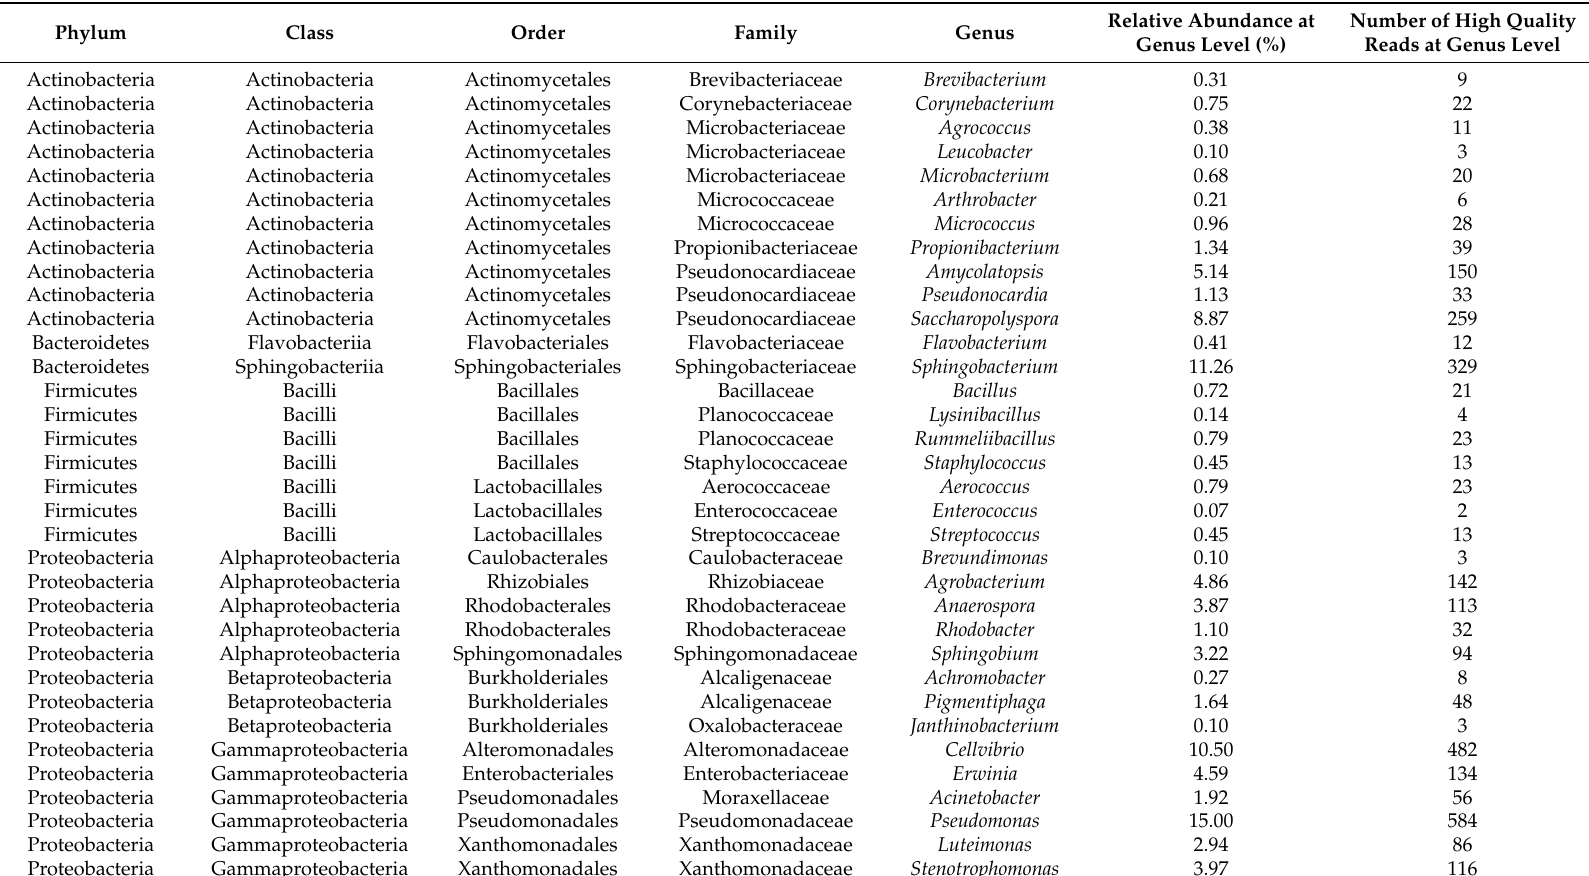
Table 1. List of all of the bacteria identified at the deepest reachable taxonomic level in the bone sample by 16S rRNA next-generation sequencing. The bacteria are reported according to their relative abundance (at genus level) without considering OTUs that have not been assigned to the genus level. For each of them, the taxonomic assignment at five phylogenetic levels (from phylum to genus), the relative abundances at genus level (the most abundant being 15% for Pseudomonas ), and the number of high-quality mapping reads are reported at the genus level. Total reads (post-quality OTU classifications) = 4244. Part of the reads (about 11%) are not assigned down to the genus level). Unidentified reads =